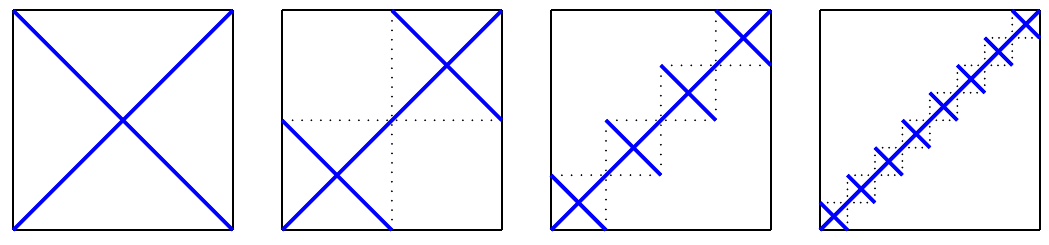
Figure 6: The supports of E 0 , E 1 , E 2 and E 3 respectively